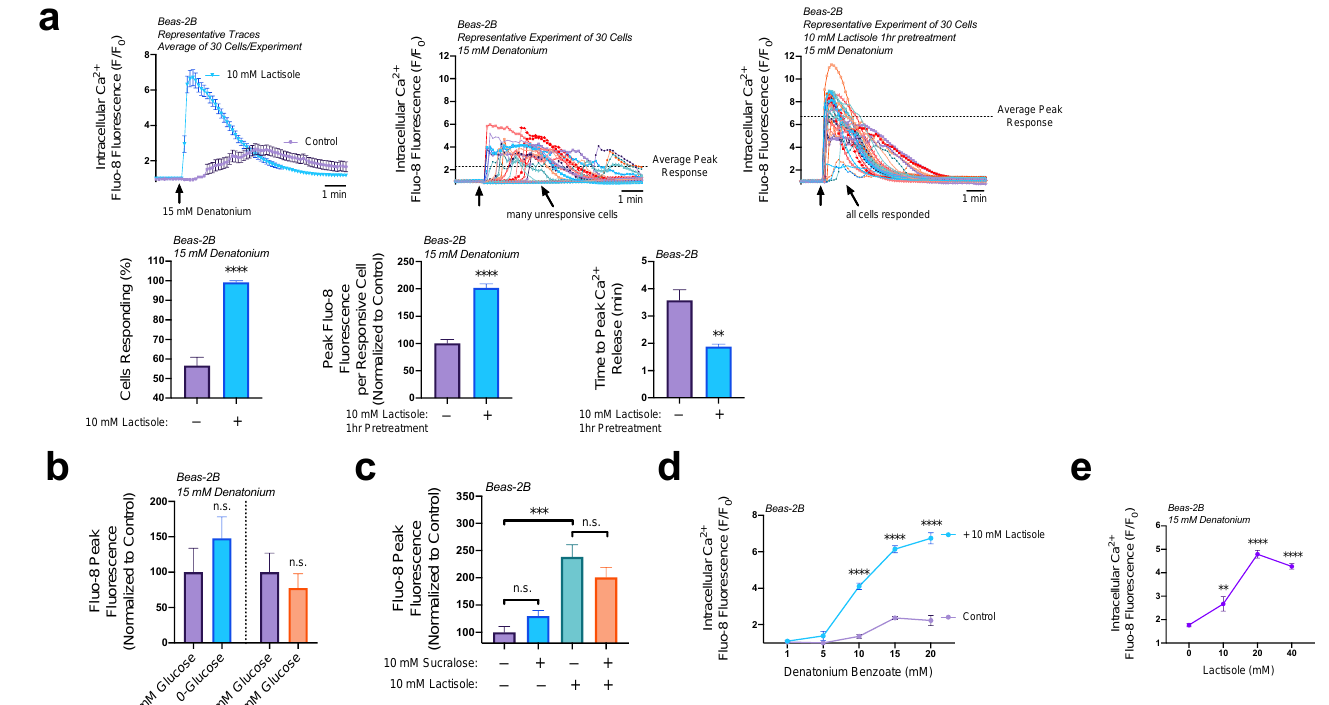
Figure 5. Lactisole increases denatonium induced Ca 2+ release. ( a ) Lactisole (10 mM, 1 h pretreatment) greatly increased denatonium induced Ca 2+ release, doubled the percentage of cells that responded to treatment with denatonium, doubled the peak Ca 2+ release per cell, and reduced the time to peak Ca 2+ release by 1.5 min. ( b ) Denatonium-induced Ca 2+ release was unaffected by glucose concentrations. ( c ) Denatonium-induced Ca 2+ release is unaffected by sweet taste receptor agonist sucralose. ( d ) Lactisole increases Ca 2+ release from various concentrations of denatonium. ( e ) The 20 mM of lactisole has an optimal effect on denatonium induced Ca 2+ signaling pathways. Bar graphs of only 2 comparisons were analyzed by Student’s t -test, bar graphs containing >2 data points were analyzed via ANOVA using ( c ) Tukey’s post-test for multiple comparisons, ( d ) Sidak’s post-test for paired comparisons, or ( e ) Dunnett’s post-test for comparison with control lacking lactisole: ** p < 0.01, *** p < 0.001, **** p < 0.0001, “ n.s. ” represents no significance.